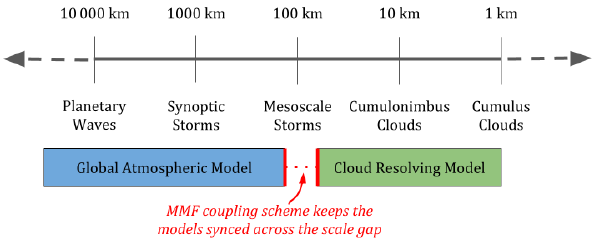
Figure 1. Schematic illustration of the scale gap created by the MMF paradigm, in which two models are coupled across a range of scales that neither can